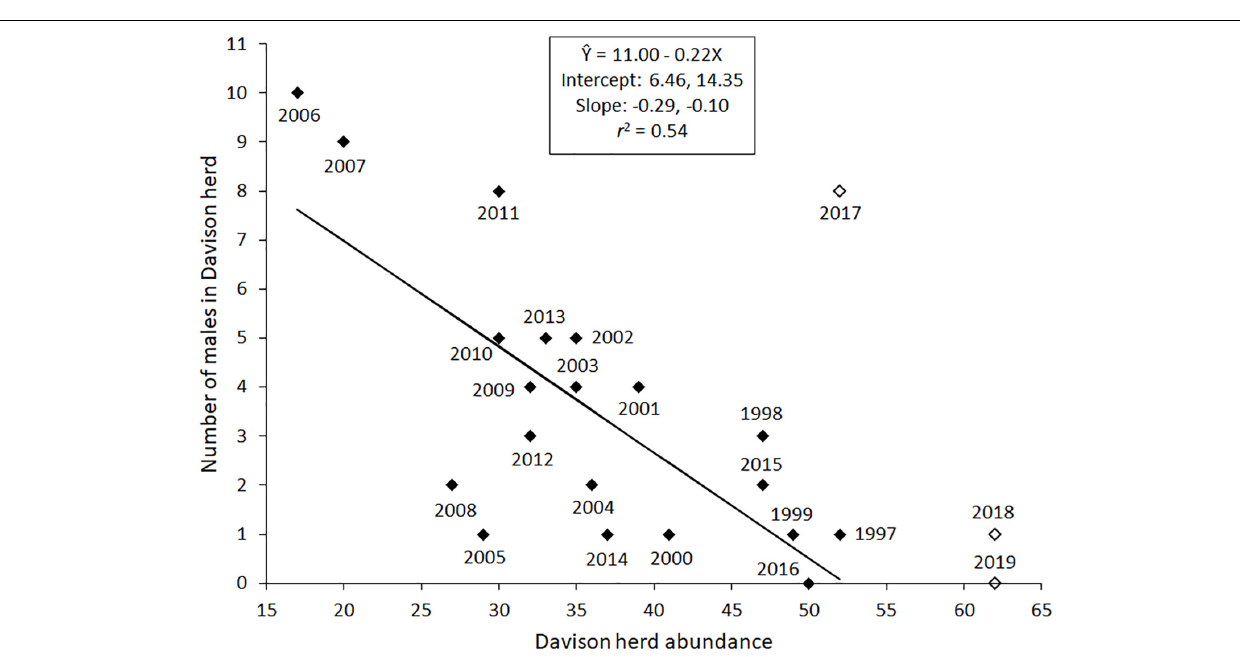
FIGURE 2 | Scatterplot of data and weighted regression estimating relationship between male abundance and male-only group size. The regression coefficients, r 2 , and lower and upper 95% confidence intervals for each regression coefficient are also reported. The dashed line represents an isometric relationship.